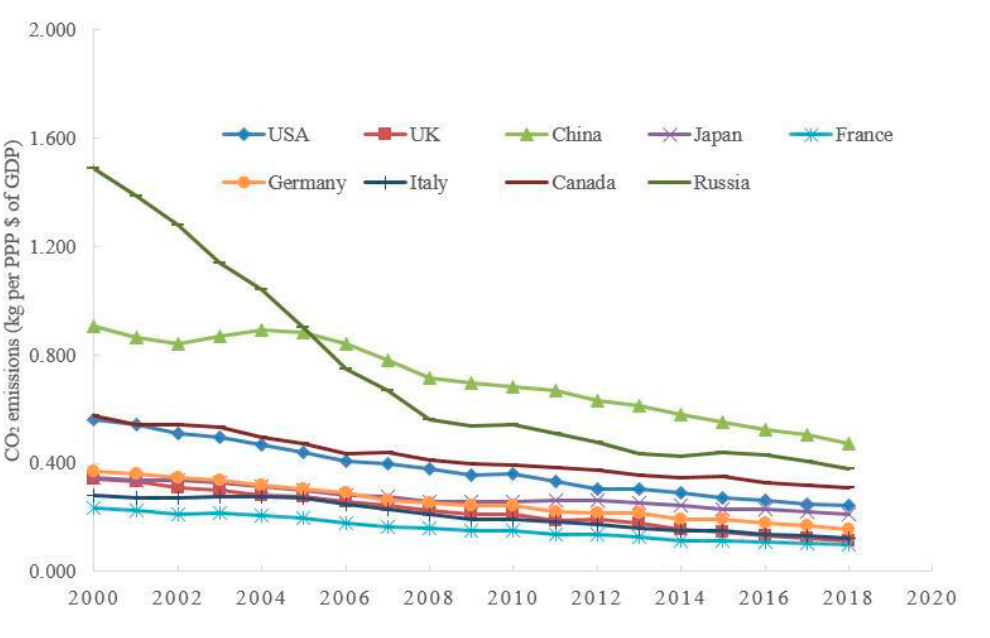
Figure 1. The trends of CO2 emissions per GDP of selected countries. Source: https://data.worldbank.org/indicator/EN.ATM.CO2E.PP.GD, accessed on 22 October 2022.